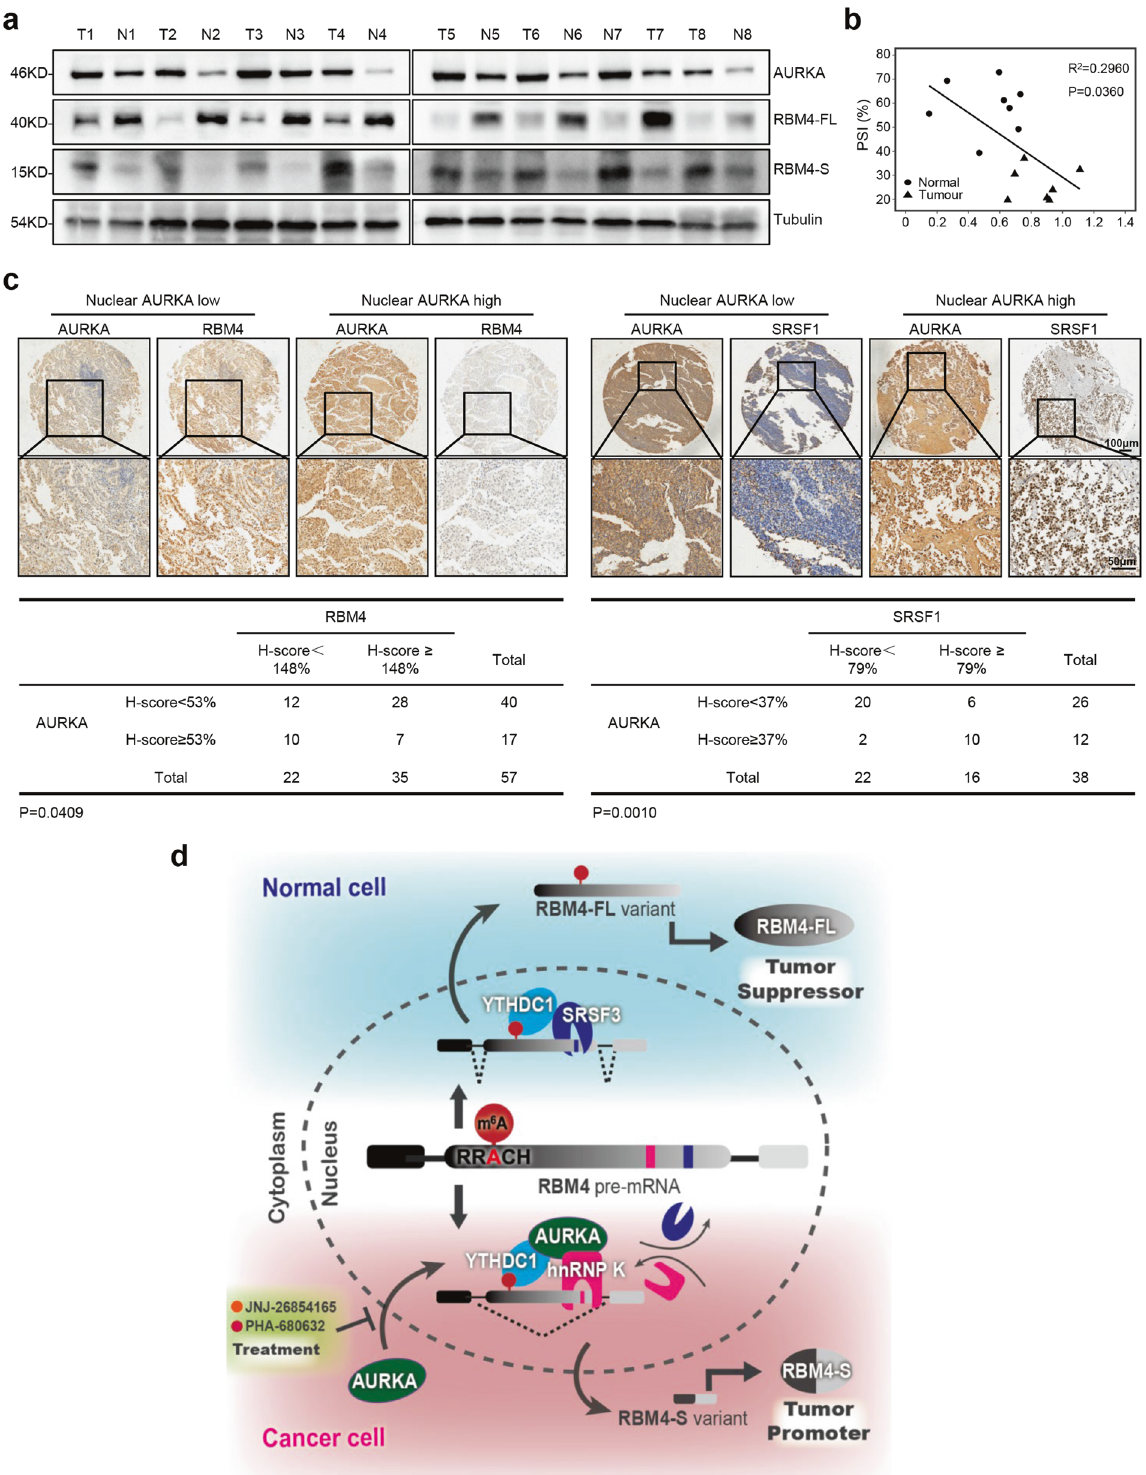
Fig. 7 Clinical relevance of AURKA-RBM4 aberrant splicing axis. a Relative protein expression levels of AURKA and RBM4-FL/S in eight pairs of NSCLC specimens (T) and adjacent normal tissues (N) were subjected to western blot analysis. b Linear regression analysis of a correlation between AURKA relative expression level and the PSI value of RBM4 in eight pairs of clinical specimens was shown. R 2 = 0.2960, P = 0.0360. c Representative images of nuclear AURKA, RBM4, and SRSF1 IHC staining in lung tumor specimens. Scale bars, 100 μ m or 50 μ m. d Schematic diagram of the mechanism: Nuclear AURKA disrupts the binding of SRSF3 to m 6 A reader YTHDC1, thereby inhibiting the production of m 6 A- YTHDC1-SRSF3-mediated tumor suppressive isoform RBM4-FL. In turn, nuclear AURKA bridges the interaction between hnRNP K and YTHDC1, thus facilitating the production of m 6 A-YTHDC1-hnRNP K-mediated tumor-promoting isoform RBM4-S. Blocking AURKA nuclear translocation, can reverse the oncogenic splicing of RBM4 and suppress lung tumor progression. Pearson ’ s correlation test in c . P < 0.05 is considered statistically signi fi cant Signal Transduction and Targeted Therapy (2022)